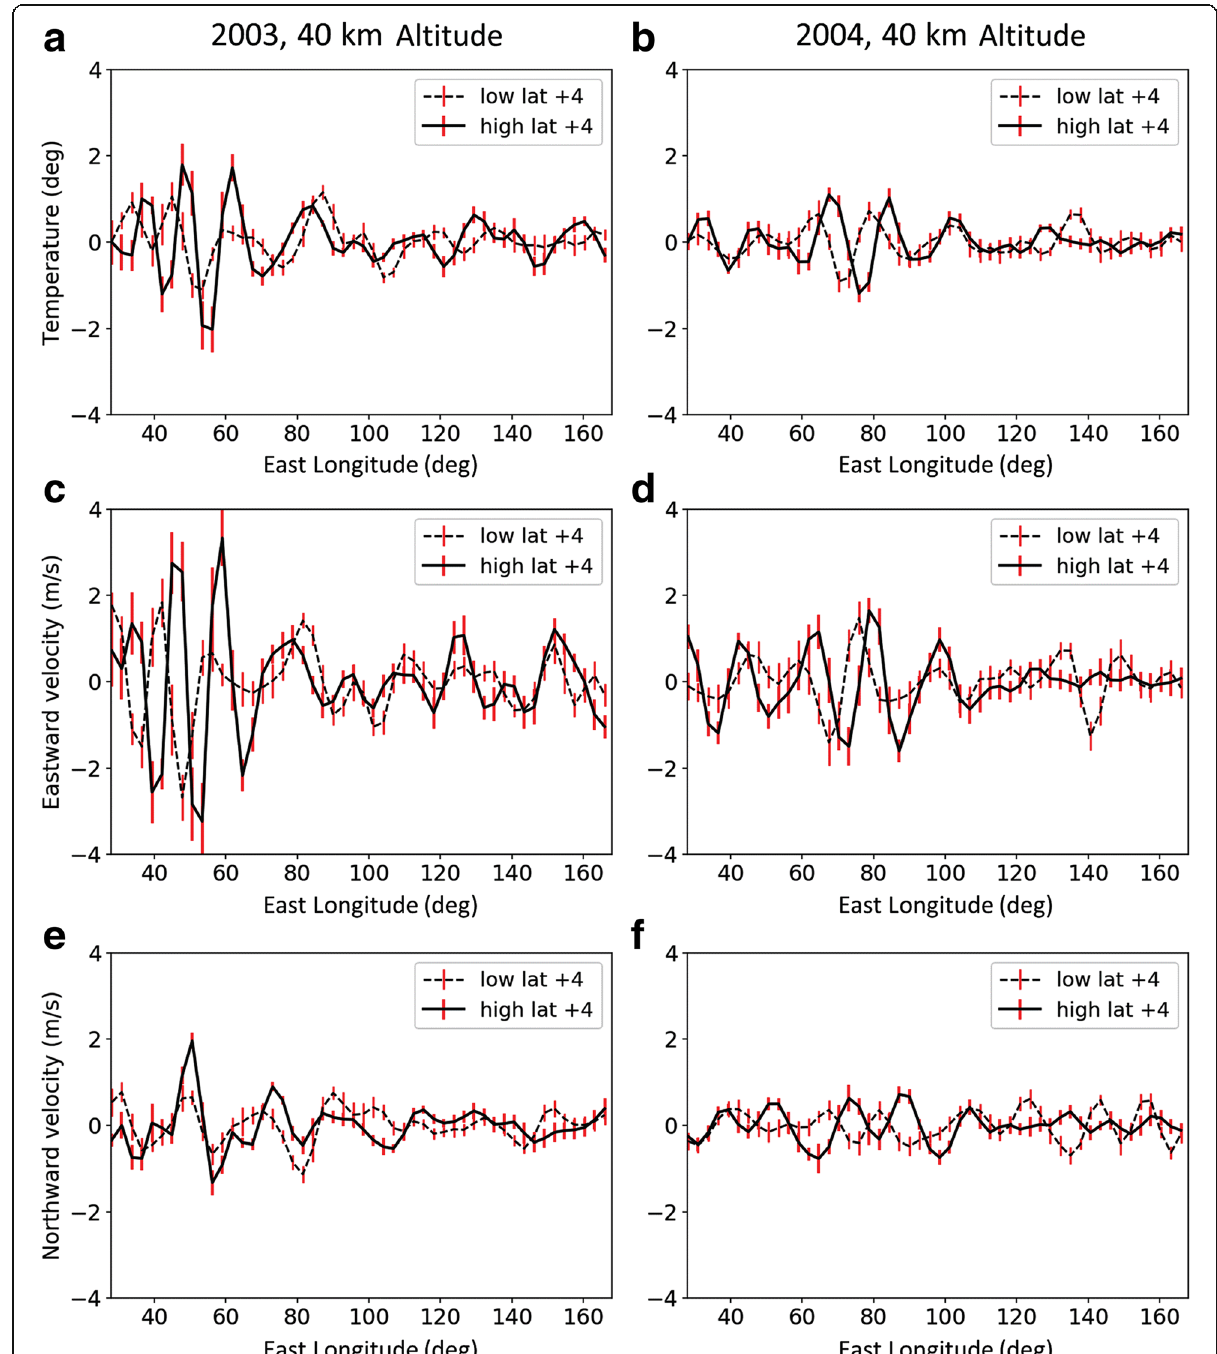
Fig. 5 Longitudinal fluctuation of GAIA parameters at 4 N latitude. The solid and dashed lines in each panel are averages over the three most EPB-active and EPB-inactive days. Further time averaging from 0630 UT to 1230 UT is applied, and the data are plotted with standard deviation bars. All data are at an altitude of 40 km. The panels are a temperature in 2003, b temperature in 2004, c eastward wind in 2003, d eastward wind in 2004, e northward wind in 2003, and f northward wind in